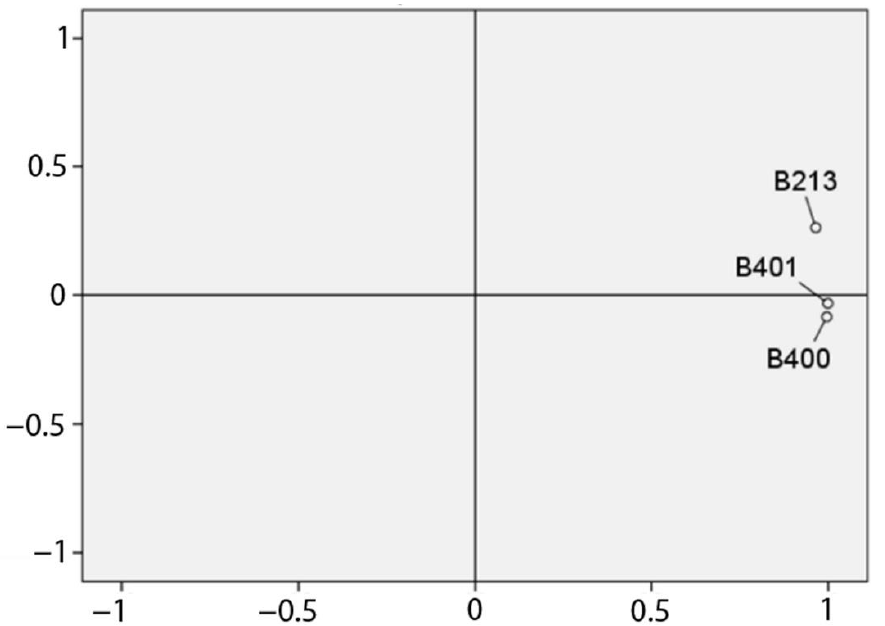
Figure 2. Principal component analysis of C. testosteroni cells titer after adding HCB to the culture medium (CFU/mL).